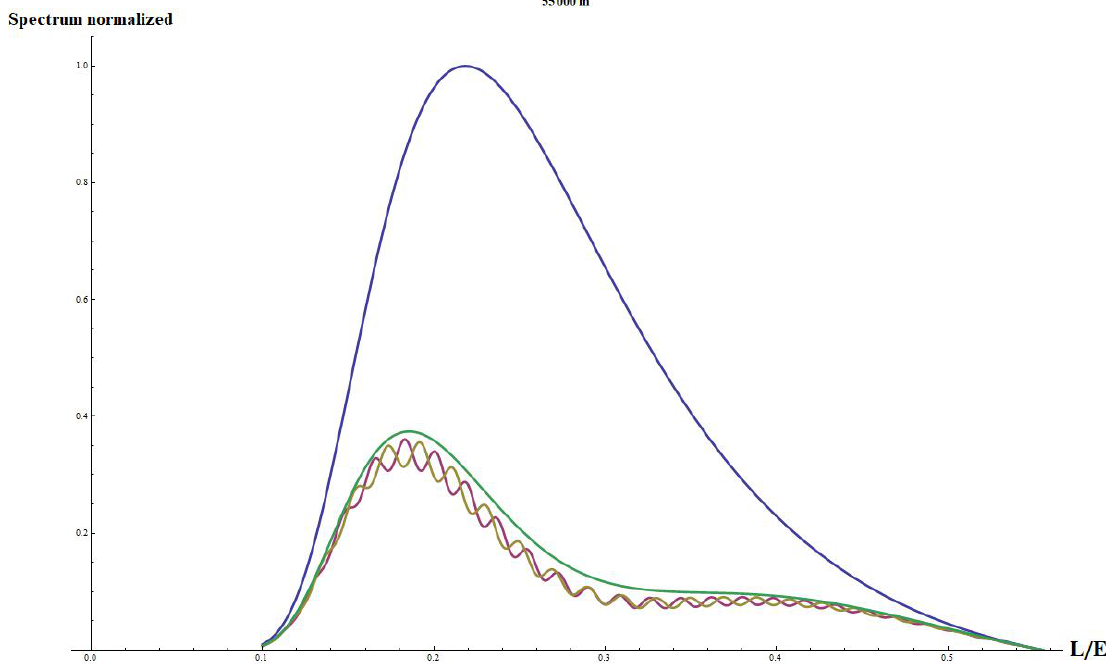
Figure 13. JUNO experiment foreseen spectrum plotted as a function of the variable L/E, for fixed baseline L=55km. Plot reproduced by the author following [96].